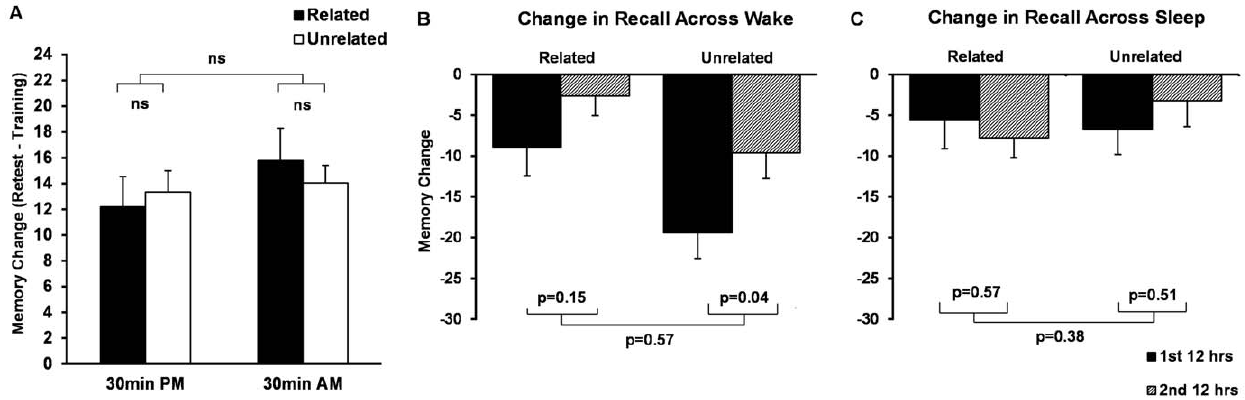
Figure 4. Memory Across the First and Second 12 hr Intervals Containing either Wake or Sleep. A. Change in recall from training to retest for Related (black bars) and Unrelated (white bars) word pairs in the 30 min groups. Bars represent % recall at training minus % recall at retest (means 6 SEMs). B. Memory (% correct) following the first and second 12 hr interval of Wake was measured as the difference following 12 hr Wake minus 30 min Morning recall (black bars) and 24 hr Immediate Sleep minus 12 hr Sleep (striped bars). C. Memory (% correct) following the first and second 12 hr interval of Sleep – 12 hr Sleep minus 30 min Evening (black bars); 24 hr Delayed Sleep minus 12 hr Wake (striped bars). Bars are means 6 SEMs.